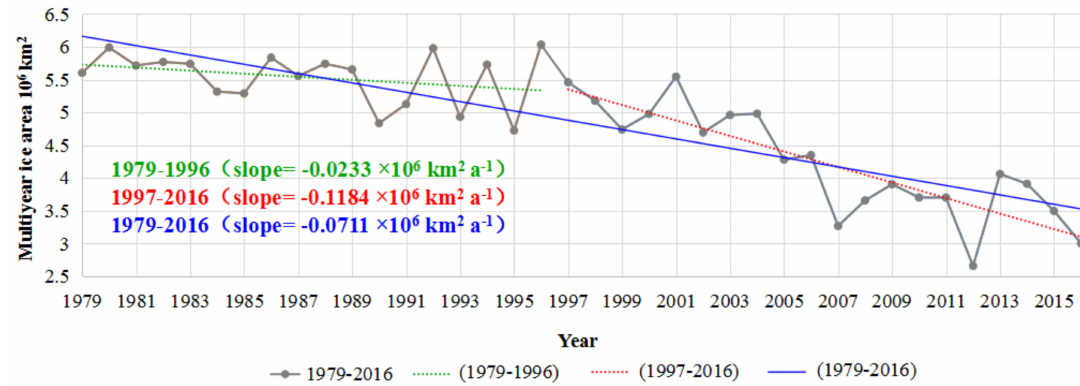
Figure 6. Trend of multiyear ice area from 1997–2016 (grey solid line: 1979–2016 yearly data; blue solid line: 1979–2016 trend; green dashed line: 1979–1996 trend; red dashed line: 1997–2016 trend).